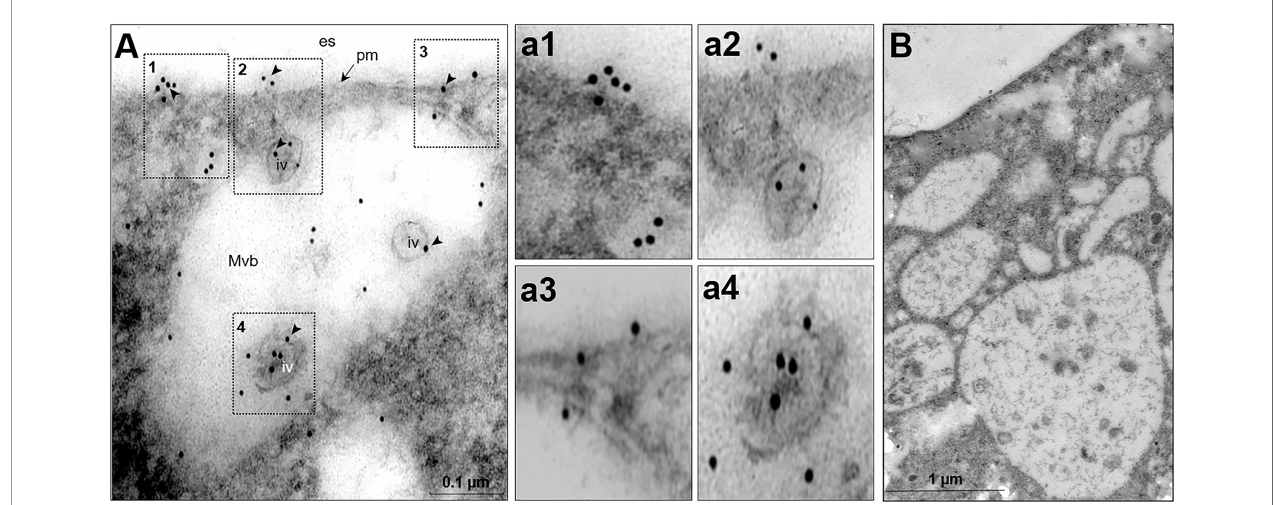
FIGURE 4 | TEM of transfected trophozoites showing the EhVps23 in MVBs. (A) Thin sections of trophozoites treated with the a -EhVps23 followed by gold-labelled a -rat antibodies. Squared areas are magni fi ed at right. (B) Control without using the fi rst